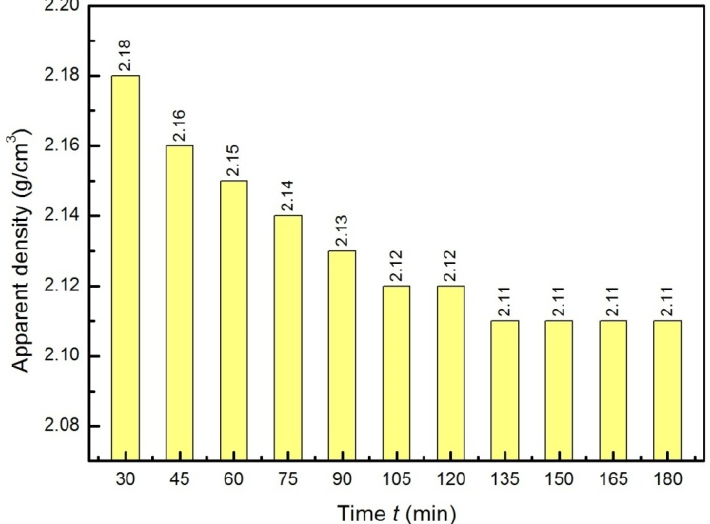
Figure 11. The effect of reduction time on apparent density (reduction temperature 350 °C).